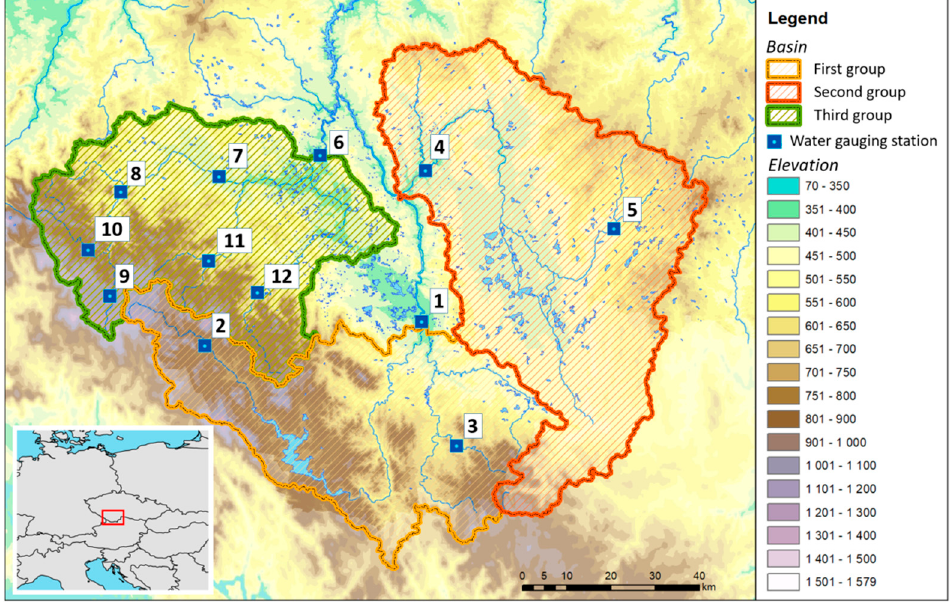
Figure 4. Locations of river profiles and their catchments.